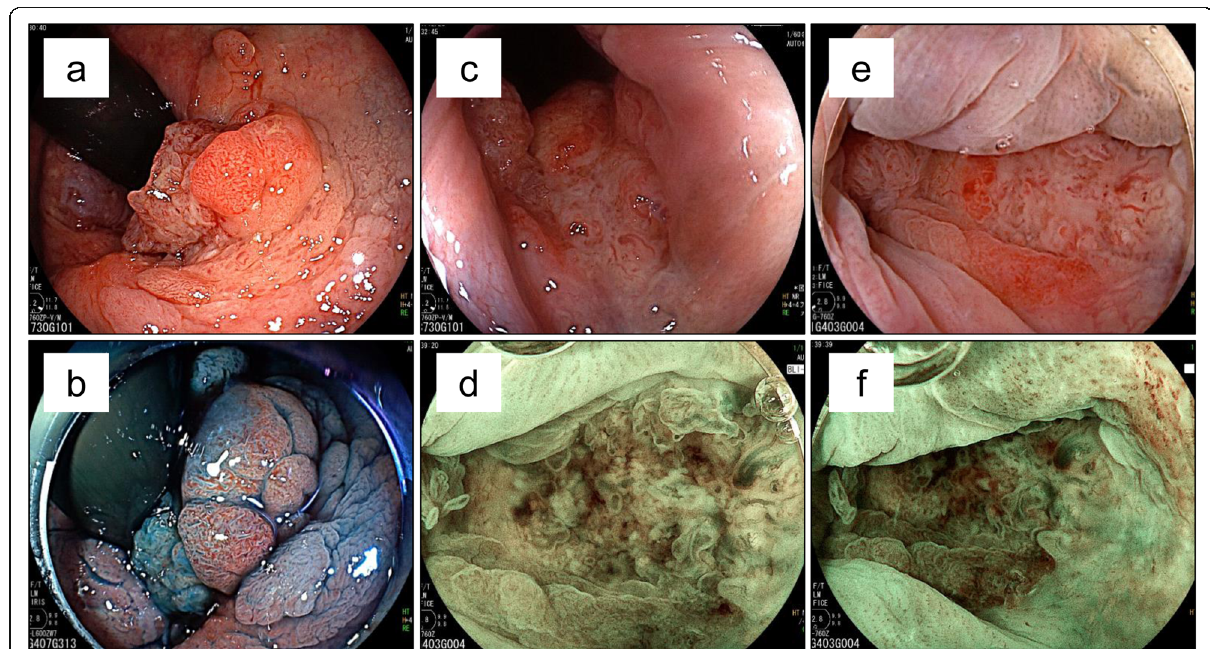
Fig. 2 Colonoscopy revealed an irregular shaped mass from the proximal anal canal to the anal